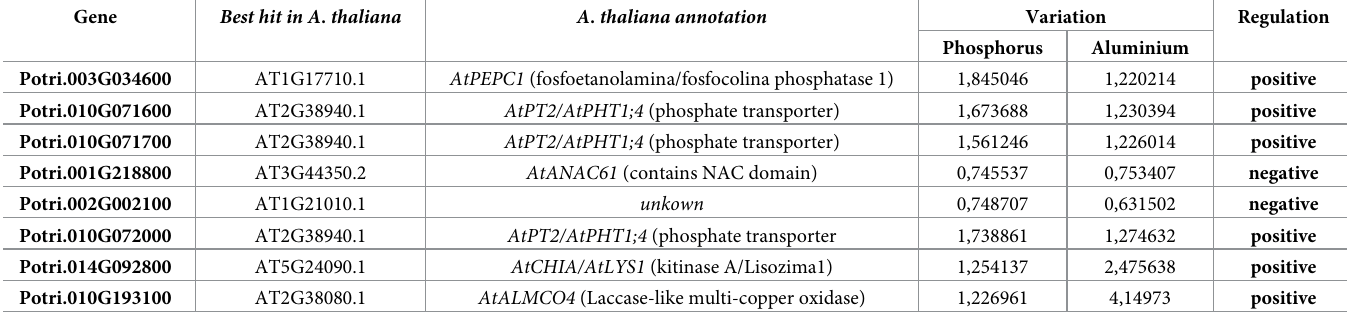
Table 4. Description of the genes of P . trichocarpa with the same regulation profile for phosphate deficit and aluminium toxicity. Gene Best hit in A . thaliana